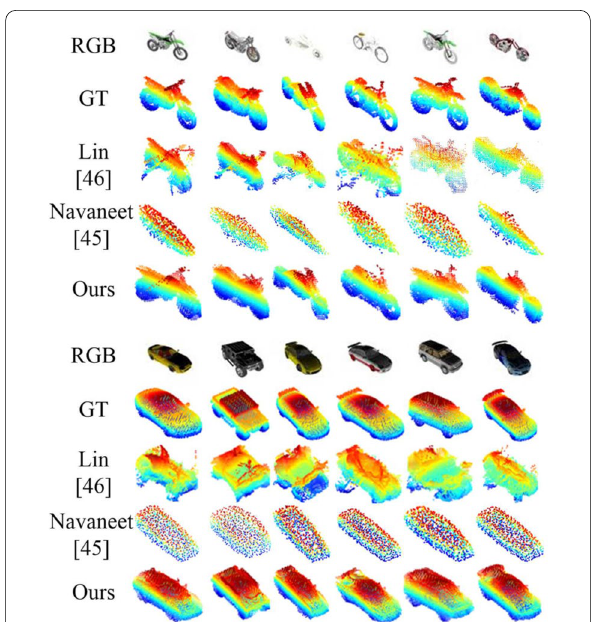
Figure 12 Out-of-category reconstructed point clouds